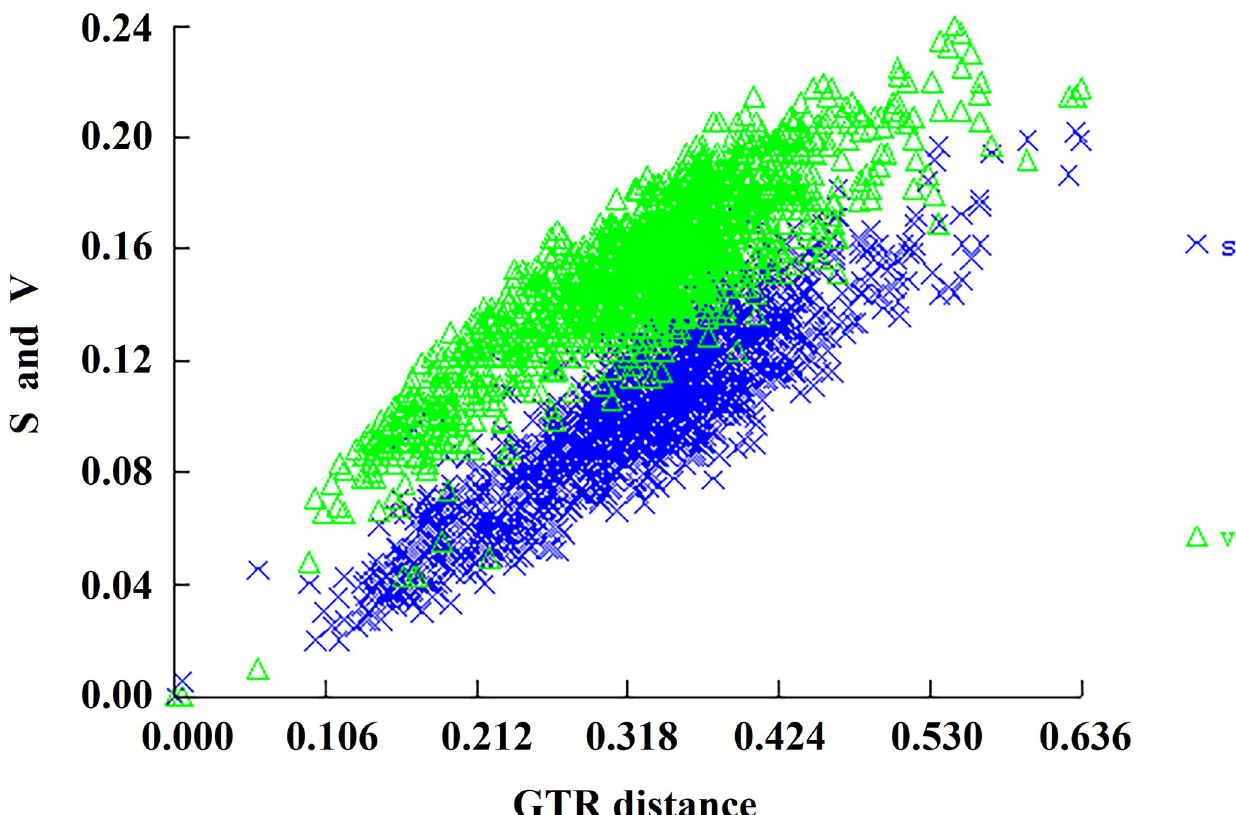
Fig 1. Saturation analysis of base substitutions in species of the family